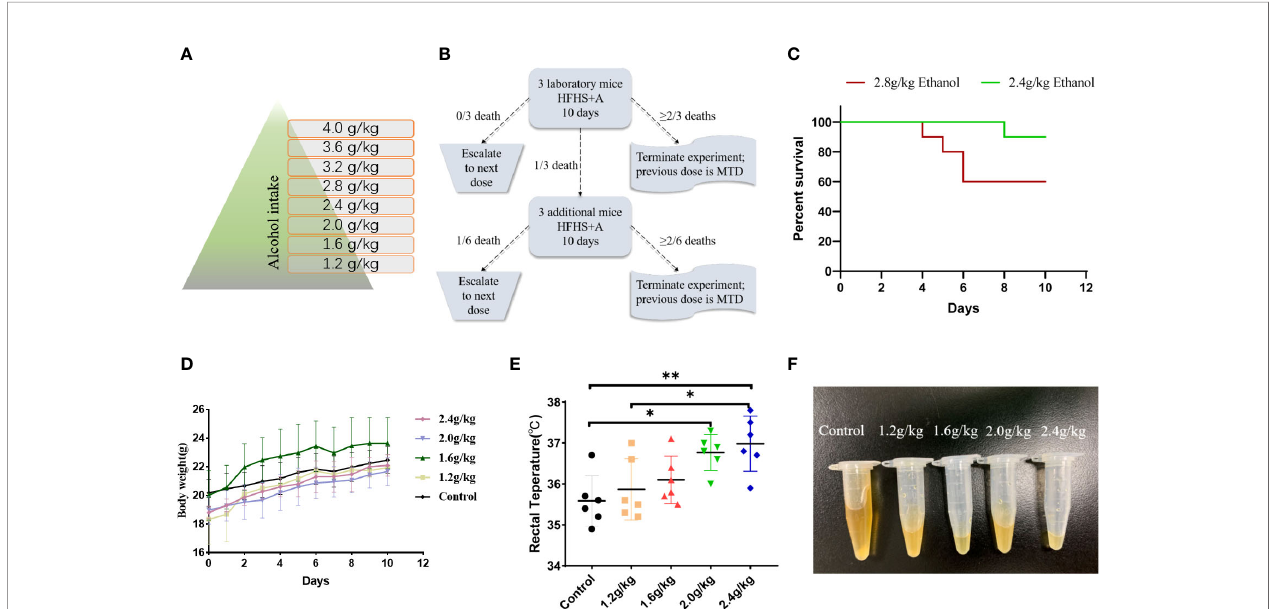
FIGURE 1 | Determination of the alcohol MTD for mice. (A) Dose incremental scheme of alcohol. (B) Exploration of the alcohol MTD for mice through the Fibonacci method. (C) Survival of mice at the critical points and above the critical point of alcohol dosage (n = 10 in each group). (D) Body weight of mice receiving different dosages of alcohol (n = 10 in each group). (E) Rectal temperature of mice receiving different dosages of alcohol (n = 6 in each group). (F) Urine volume of mice receiving different dosages of alcohol (n = 6 in each group). *p < 0.05, **p <